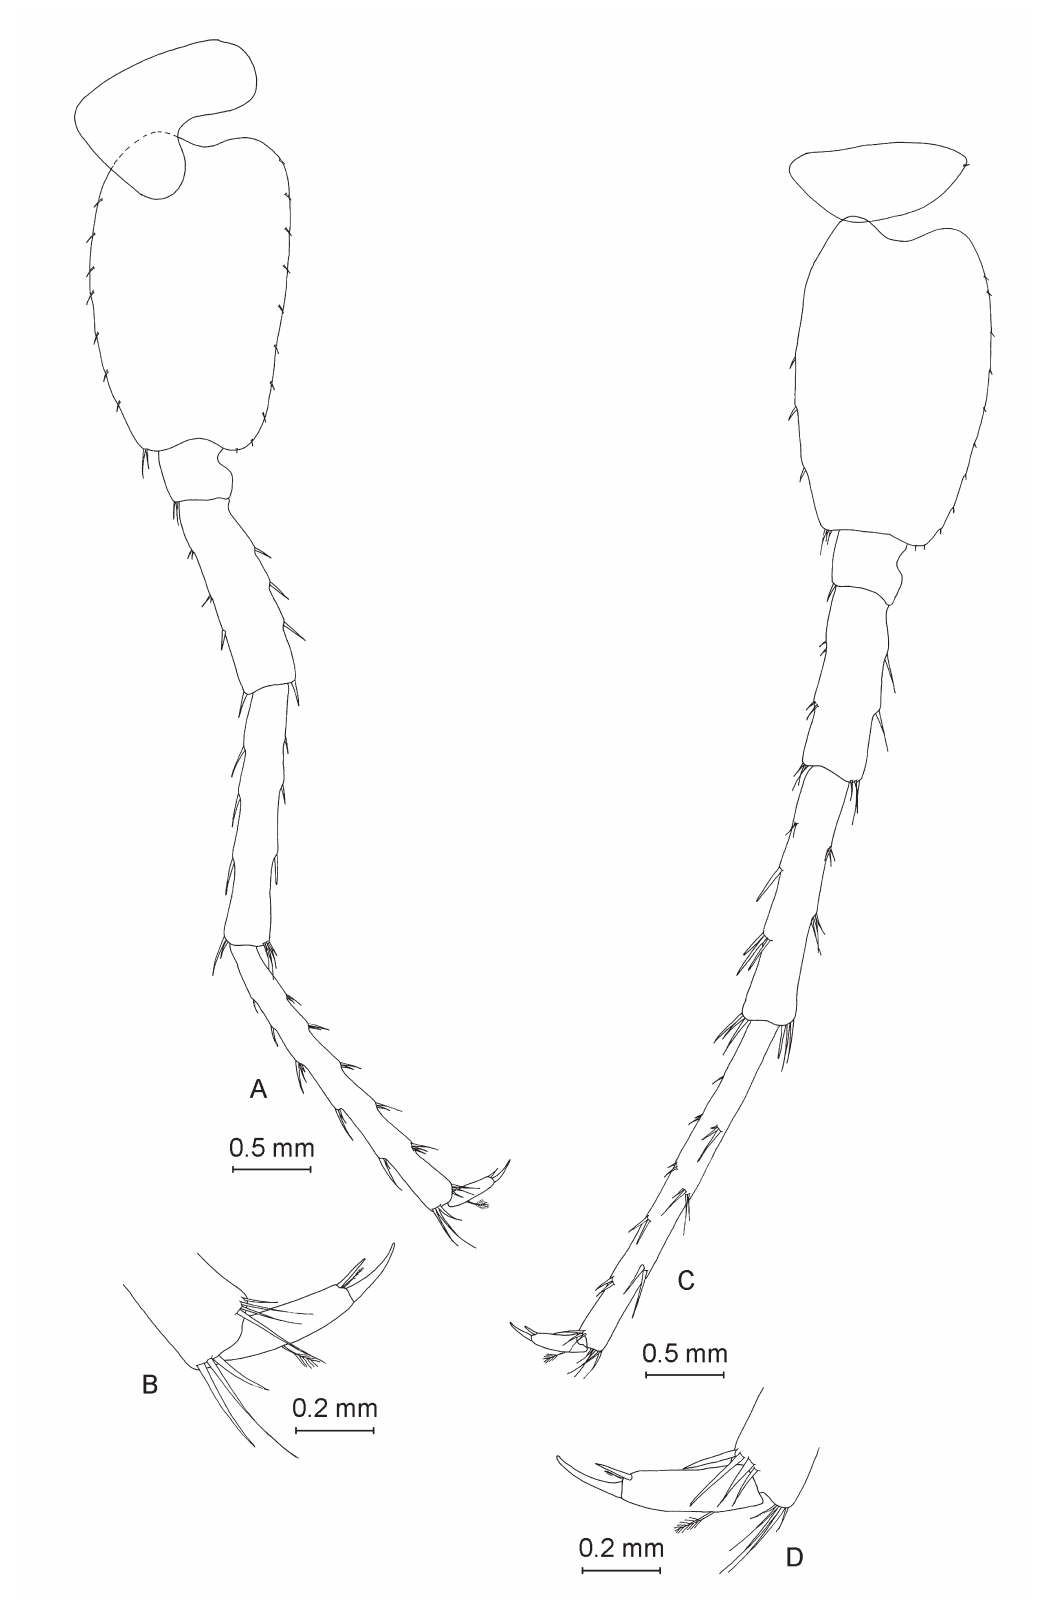
Fig. 7. ♂. A . Pereopod VI. B . Dactylus of pereopod VI. C . Pereopod VII. D . Dactylus of pereopod